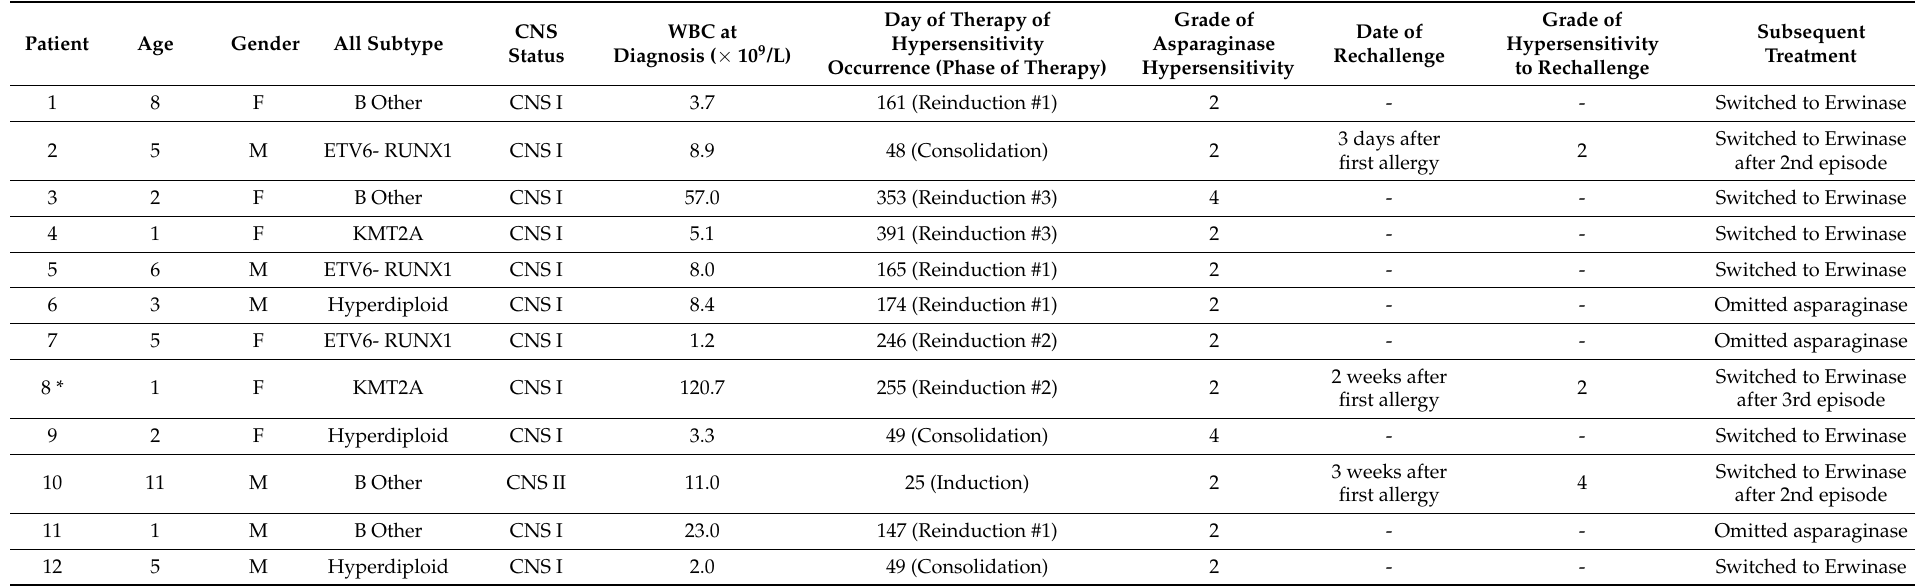
Table 1. Clinical profiles of patients with asparaginase-related